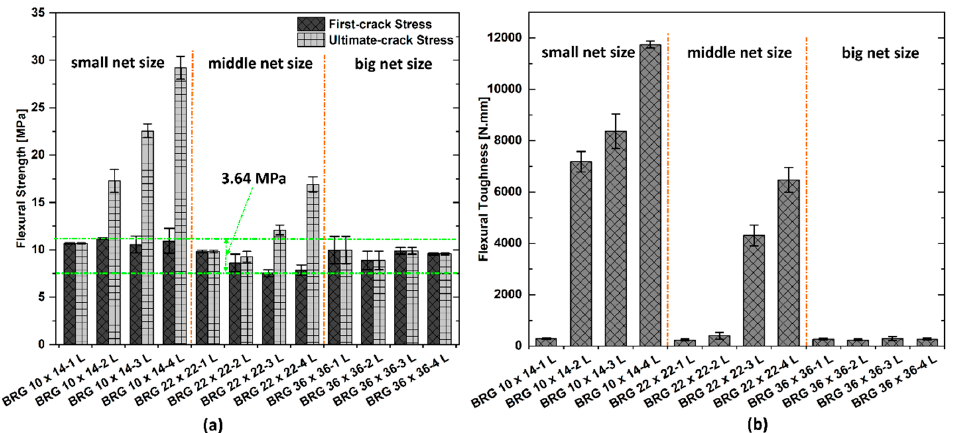
Figure 10. The comparison of the flexural strength (a) and flexural toughness (b) of the BRG specimens corresponding to various net size and number of textile